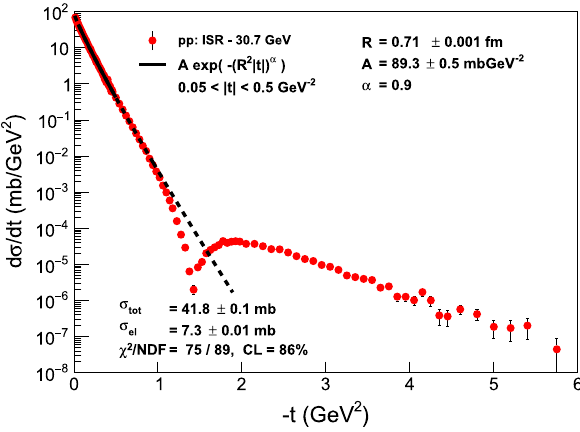
√ Fig. 40 Zeroth-order Lévy fits to the cone region of the differential s = 30 . 7 GeV [45], cross-section data on pp elastic scattering at with fixed α = 0 . 9, A and R being free fit parameters